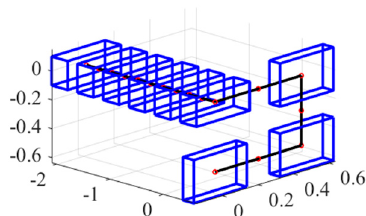
Figure 18. Final configuration of SMSRS in case 2.